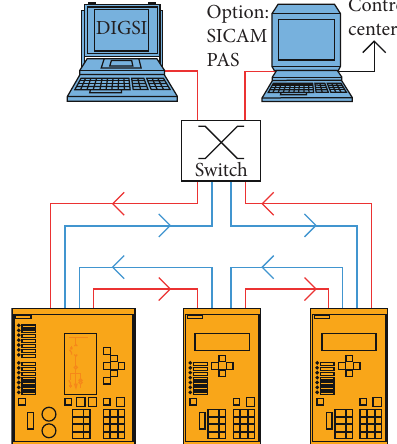
Figure 6: Bus structure for station bus with Ethernet and IEC